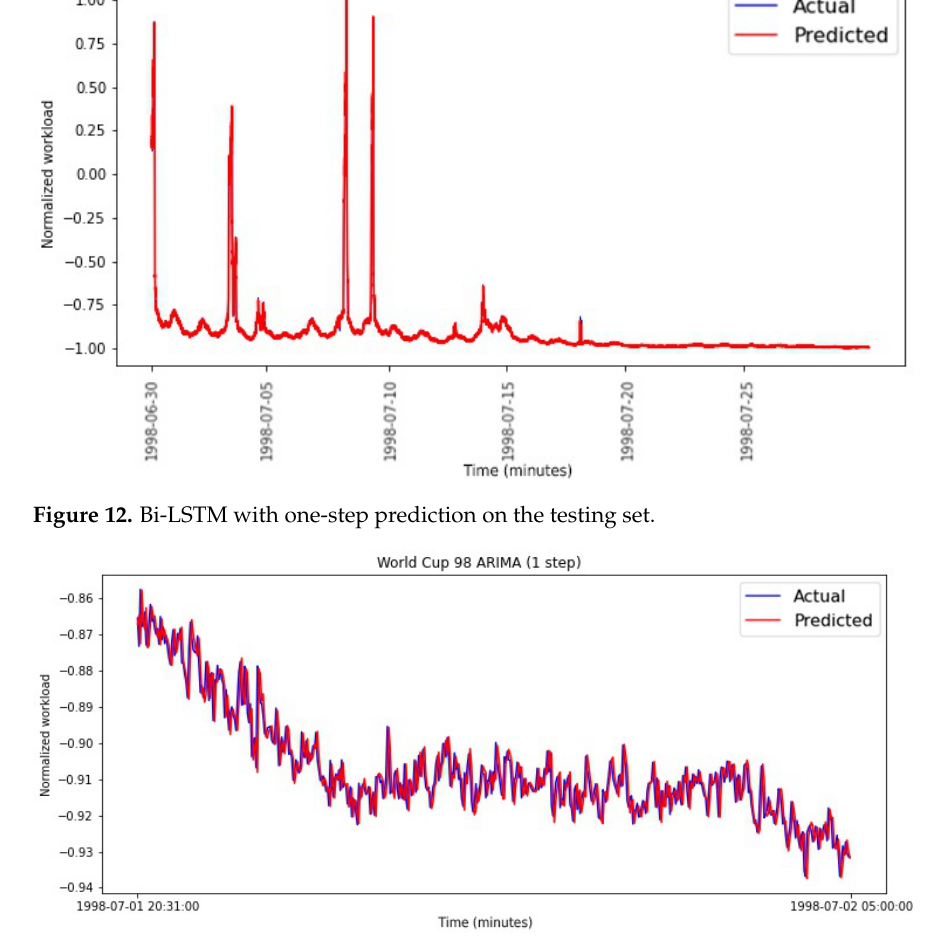
Figure 13. ARIMA with one-step prediction on the testing set (from 1 July 1998 20:31:00 to 2 July 1998